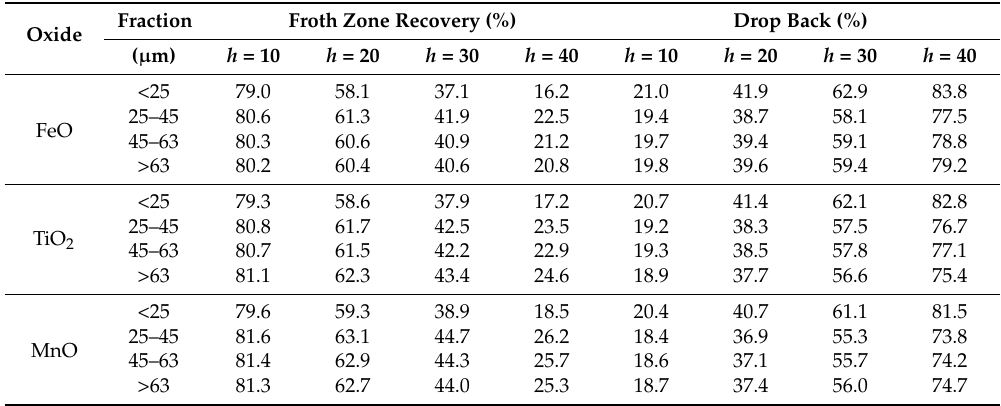
Table 6. Froth zone recovery by entrainment of the three different oxides of the four size fractions for four froth heights